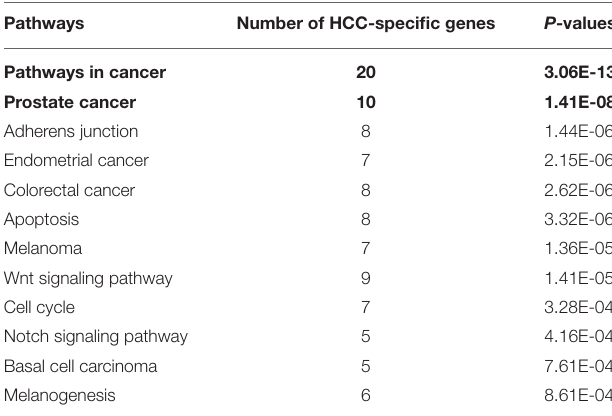
TABLE 6 | Twelve enriched tissue-specific KEGG pathways with